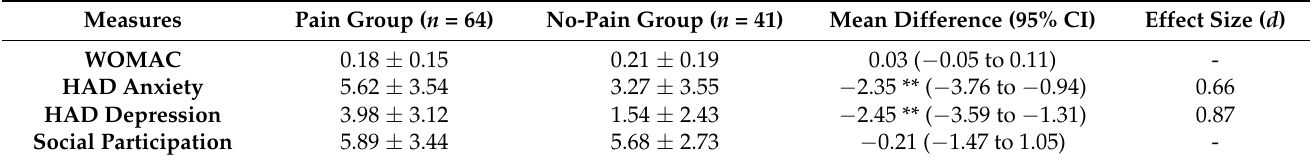
Table 2. Between-group comparisons.